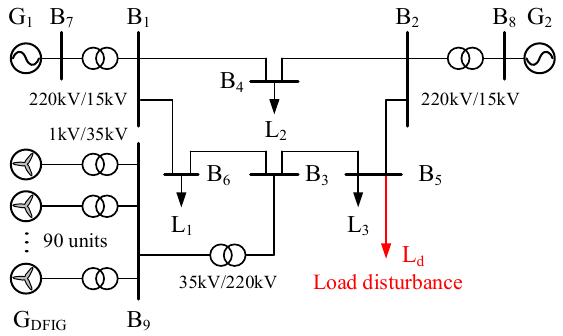
Figure 13. Topology of the grid-connected wind farm scenario.